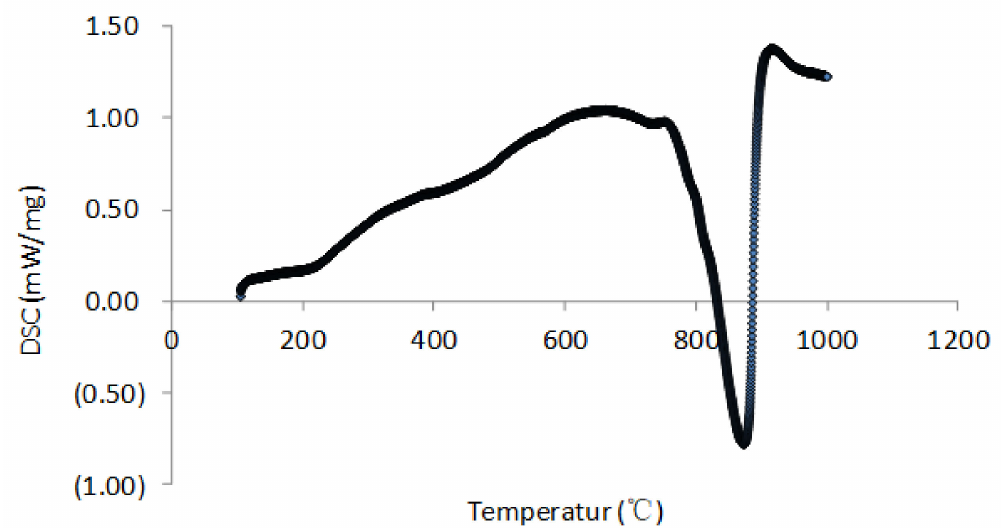
Figure 2. Heat flow change of WCP with di ff erential scanning calorimetry (DSC)